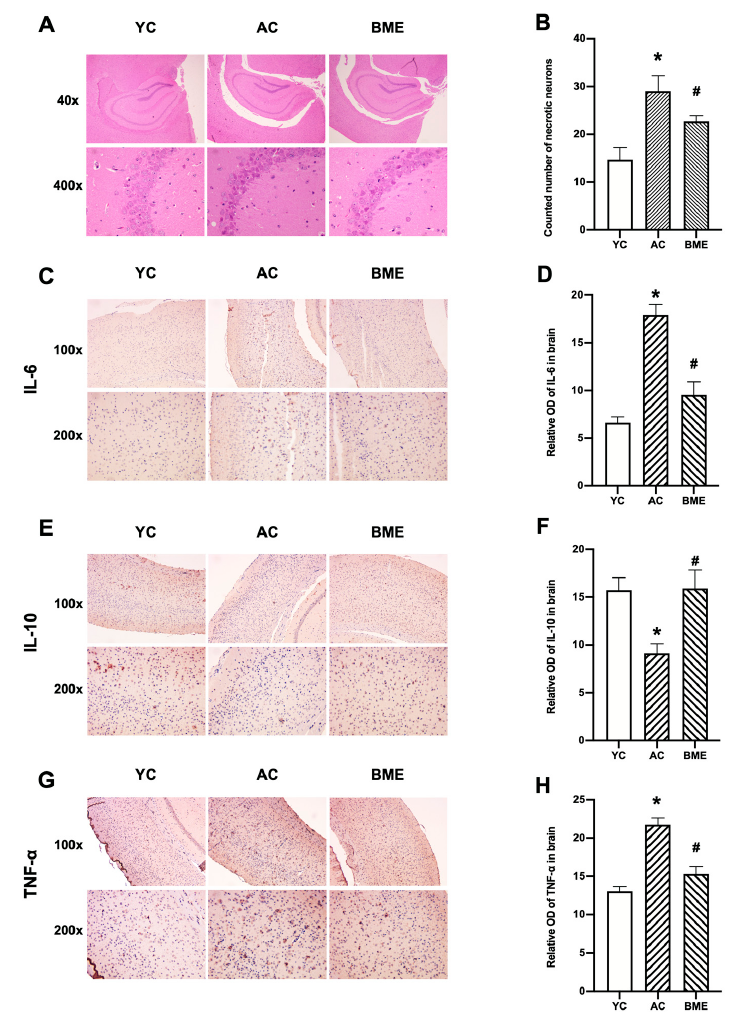
Figure 2. Histological morphology, immunohistochemical staining, and optical density (OD) values of cytokines in mouse brains. ( A ) HE staining of mouse brains. ( B ) The necrotic neurons per field in the CA3 region were counted. Representative micrographs of ( C ) IL-6, ( E ) IL-10, and ( G ) TNF- α immunostaining visualized with DAB and counterstained with hematoxylin. Integrated OD values of ( D ) IL-6, ( F ) IL-10, and ( H ) TNF- α were used to analyze the results of the immunohistochemistry. All results are expressed as means ± SEMs ( n = 3). * p < 0.05 versus YC group, # p < 0.05 versus AC